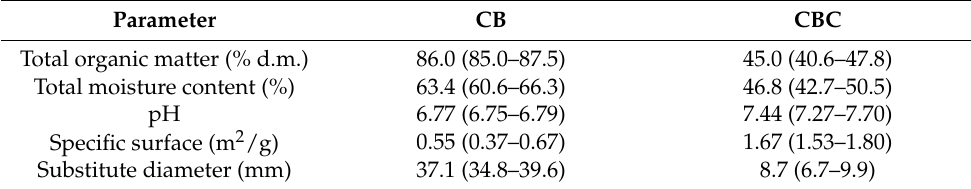
Table 1. Parameters (mean values and ranges in parentheses) of the biofilter bed materials: Stump- wood chips and pine bark (CB), and stumpwood chips, pine bark, and compost from green waste (CBC) [30,31]. Parameter CB CBC Total organic matter (% d.m.)